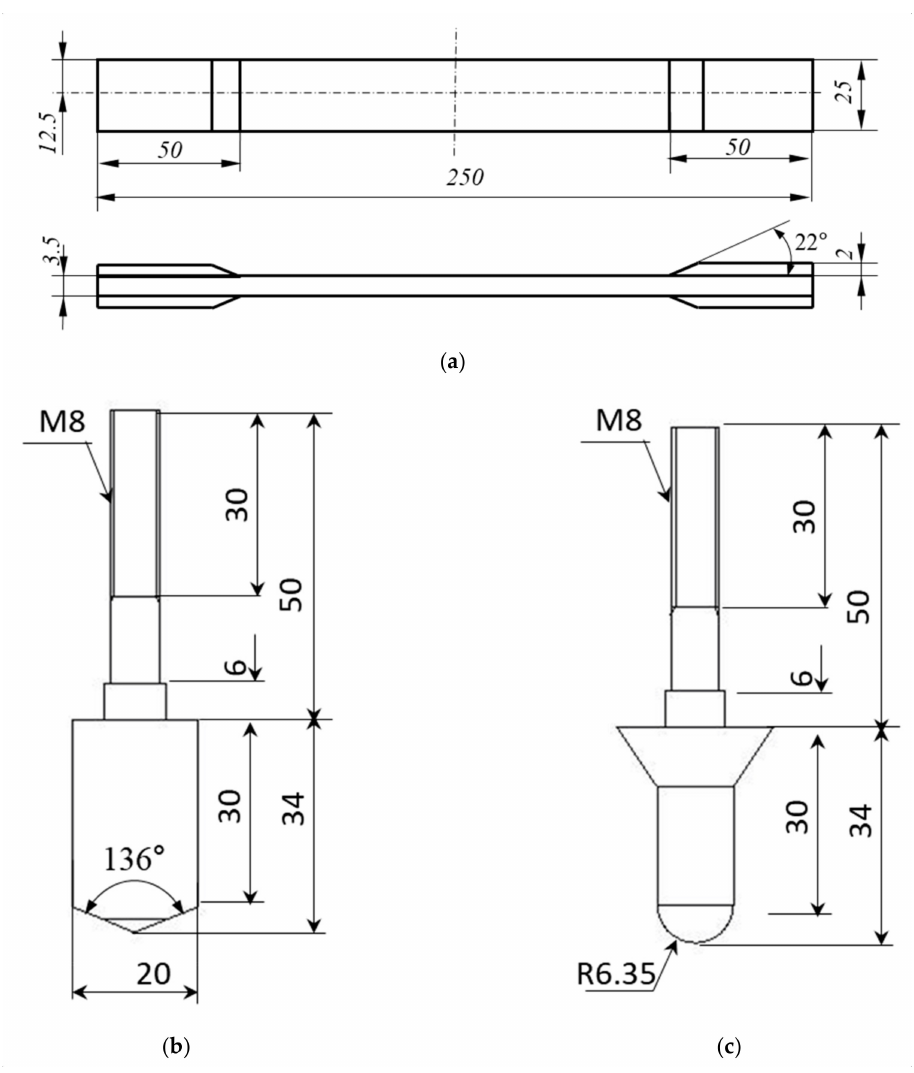
Figure 1. Geometry and dimension of ( a ) tensile specimen, ( b ) pyramidal impactor and ( c ) hemispherical